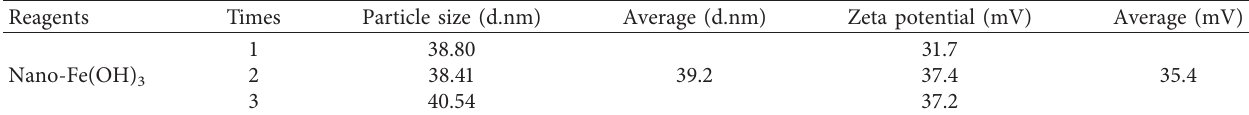
Table 2: The properties of the nano-Fe(OH)